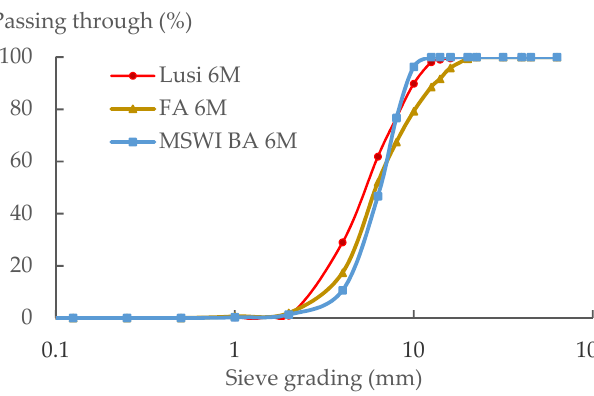
Figure 5. Particle size distribution of the LWA.